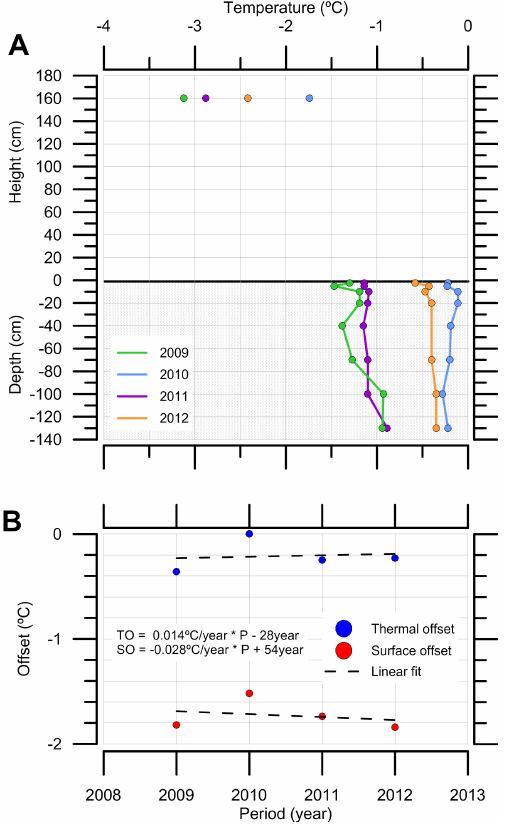
Figure 4. (A) Thermal profiles showing minimum (blue), mean (green) and maximum (red) temperatures of the ground at different depths in 2009, 2010, 2011 and 2012, and equations of the linear fitting curve to the maximum temperatures. (B) Exponential fitting curves to the thermal amplitudes of the ground at different depths, and their corresponding equations, to calculate the top of the per- mafrost depth.